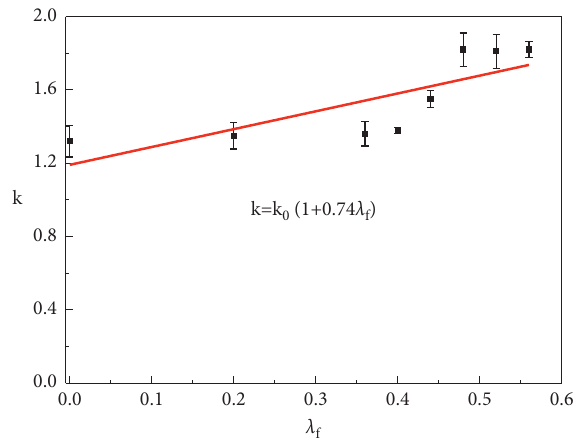
Figure 5: Relationship of λ